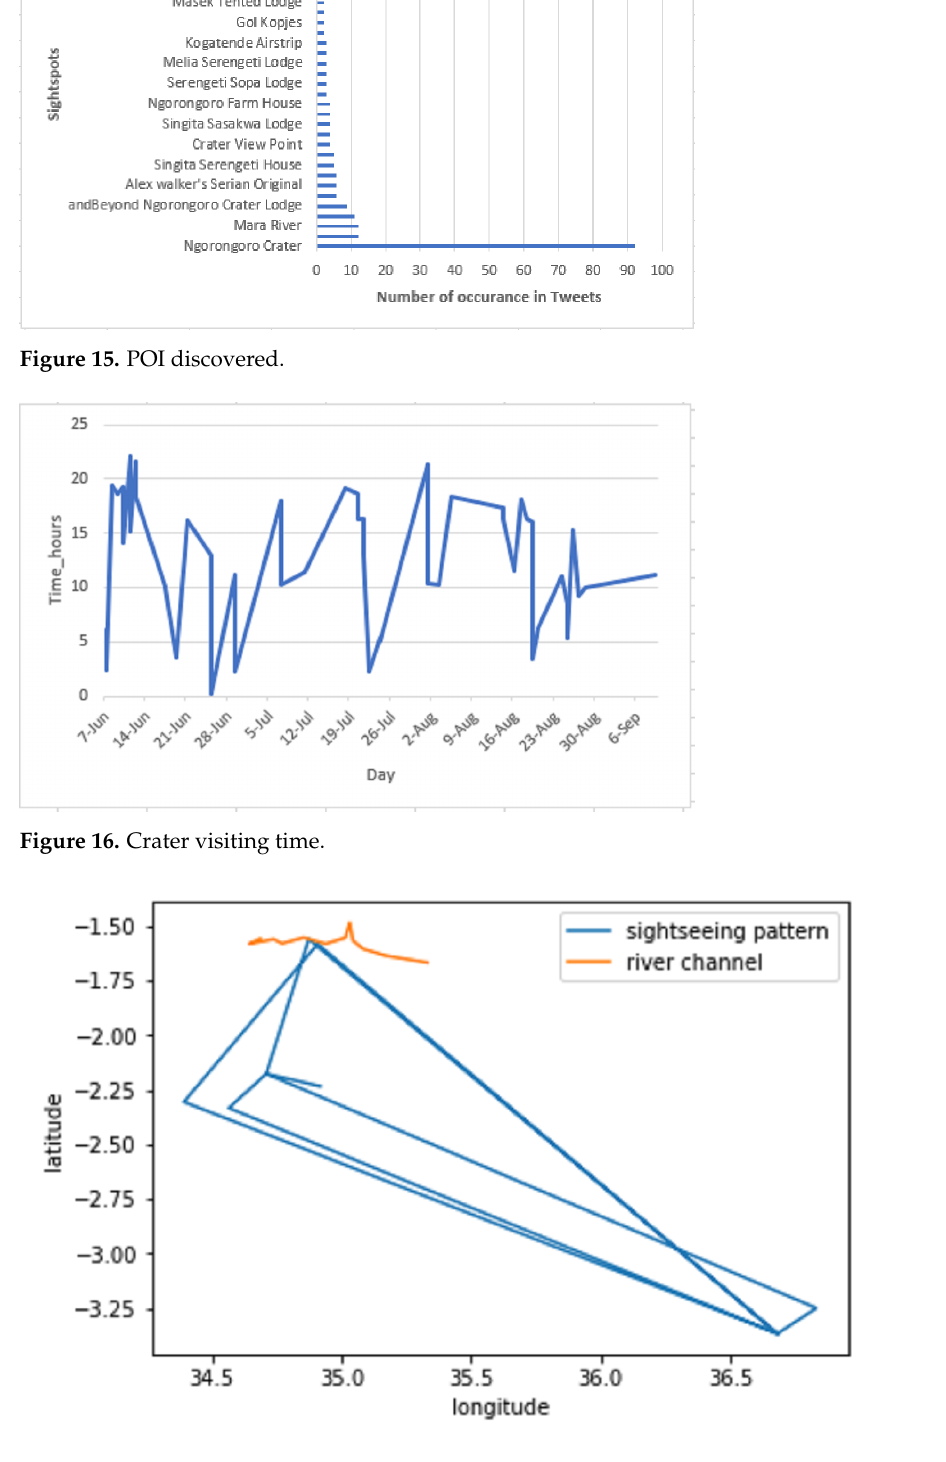
Figure 17. Observed wildebeest migration viewing